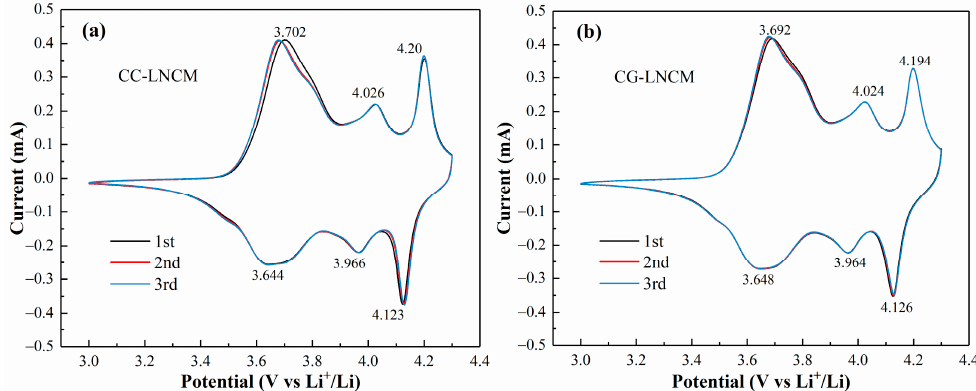
Figure 5. The fi rst three cycles of cyclic voltammograms of ( a ) CC-LNCM and ( b ) CG-LNCM at 0.1 Figure 5. The first three cycles of cyclic voltammograms of ( a ) CC-LNCM and ( b ) CG-LNCM at mV s − 1 in the potential range of 3.0–4.3 V (vs. Li + /Li). 0.1 mV s − 1 in the potential range of 3.0–4.3 V (vs. Li +